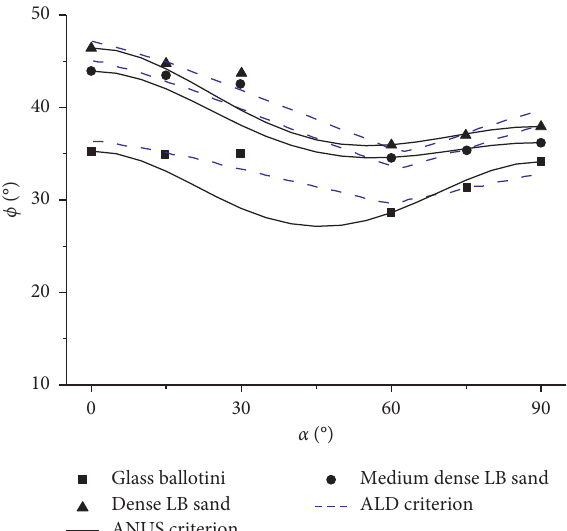
Figure 8: Verifications of ANUS criterion for different granular materials (data from [37]).